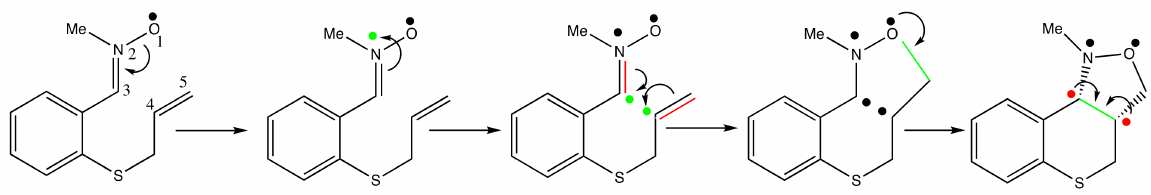
Figure 7. ELF basin isosurfaces ( η = 0.7) of each of the SSDs found along the IRC associated with TS3-a . Color labeling of the basins is adopted according to Figure 6.